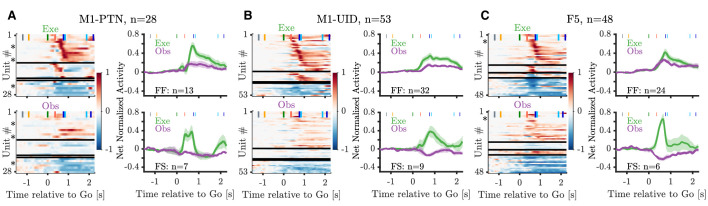
Mirror neuron population activity during PG.(A) Left panels show heatmaps of net normalized activity of PG MNs within the M1-PTN population. Neurons are split into facilitation-facilitation, facilitation-suppression, suppression-facilitation, and suppression-suppression categories based on the sign of their modulation during action execution (top) and observation (bottom) relative to baseline. Horizontal black lines mark splits between categories. Within each category, neurons are sorted based on the latency of their absolute peak response during execution (peak calculated between GO and HO+0.5 s). Asterisks denote units shown in Figure 4. Population averages are shown for F-F (top right panel) and F-S categories (bottom right panel). (B) Same as (A) but for M1-UIDs. (C) Same as (A) but for F5.